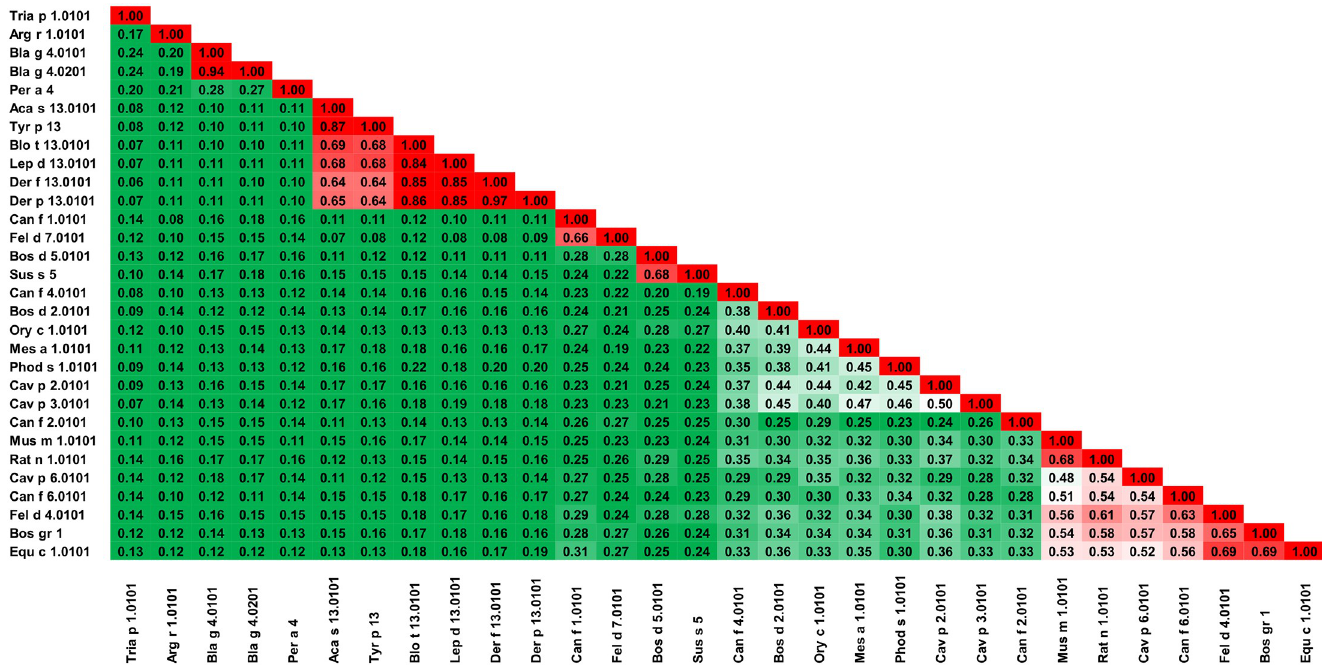
Fig 11. Plot showing A-RISC index values for allergen pairs from lipocalin family of proteins. Red color indicates a high risk of cross-reactivity, a dark green color indicates a low risk of cross-reactivity, and intermediate colors correspond to a medium risk of cross-reactivity.